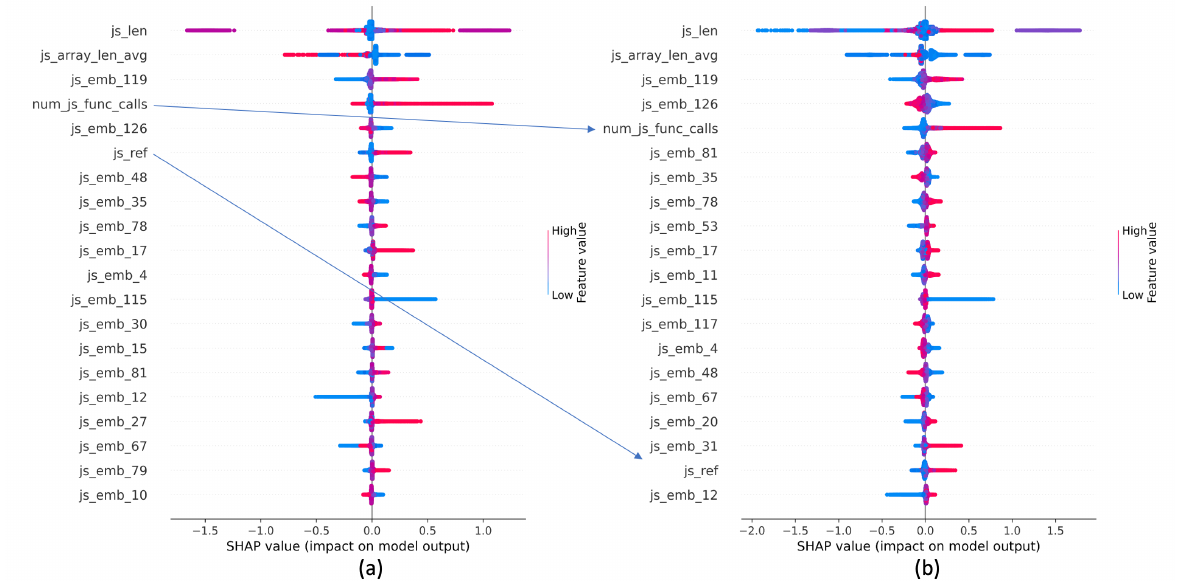
Figure 9. Top 20 features based on SHAP values: ( a ) full dataset; ( b ) dataset containing JavaScript